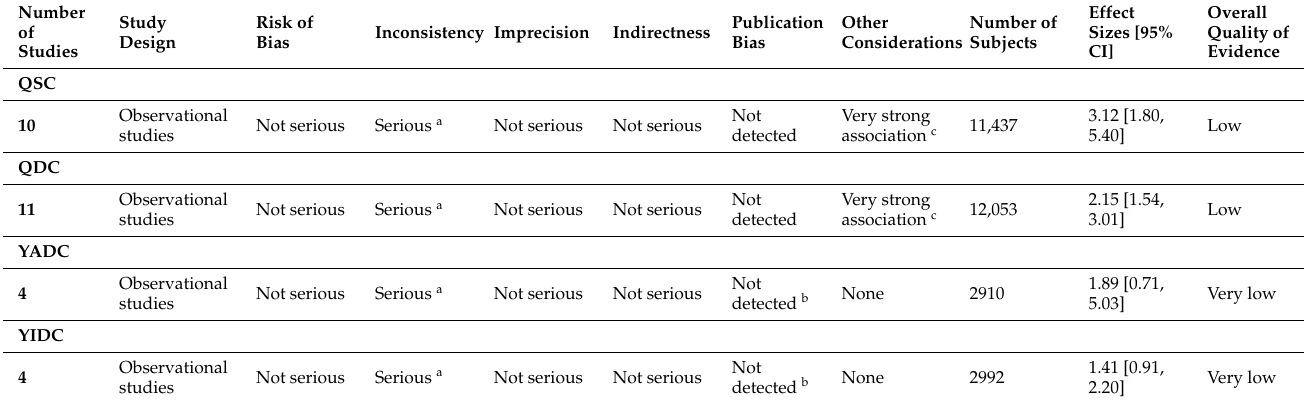
Table 4. GRADE assessment of all meta-analyses.